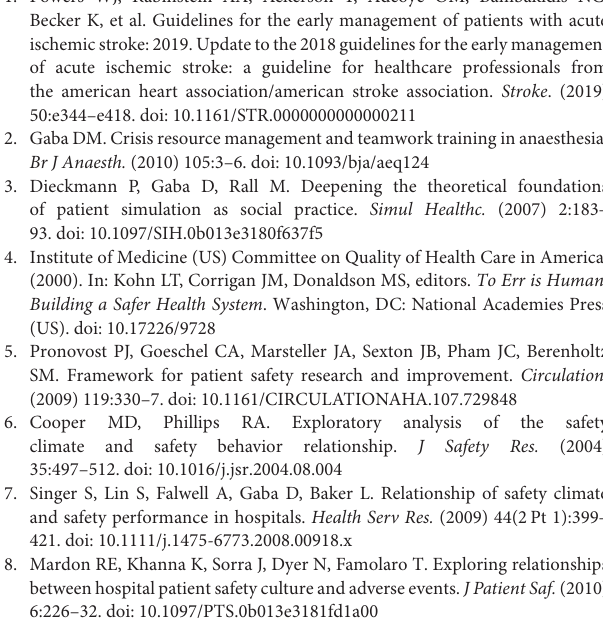
Supplementary Table 2 | Items response rate, means, reliability characteristics and factor